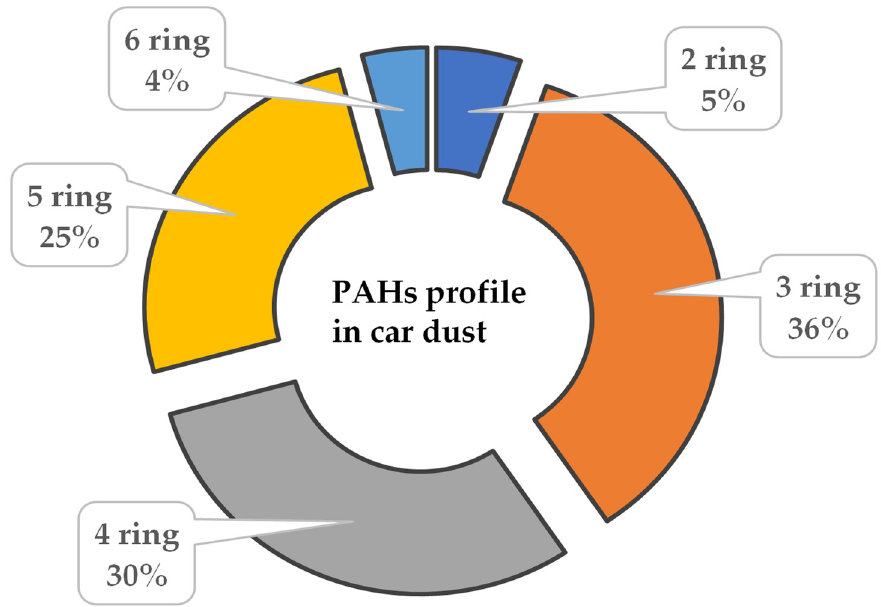
Figure 3. Contribution of ring-based PAHs in car dust.